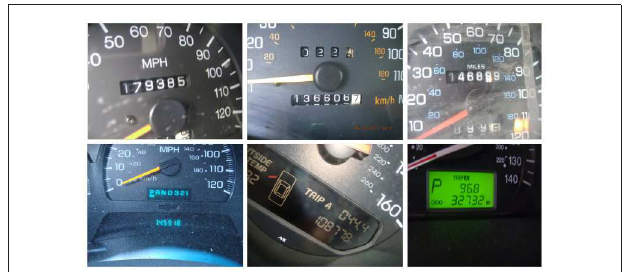
FIGURE 4 | Sample annotations. (A) Labeling odometer display. (B) Labeling